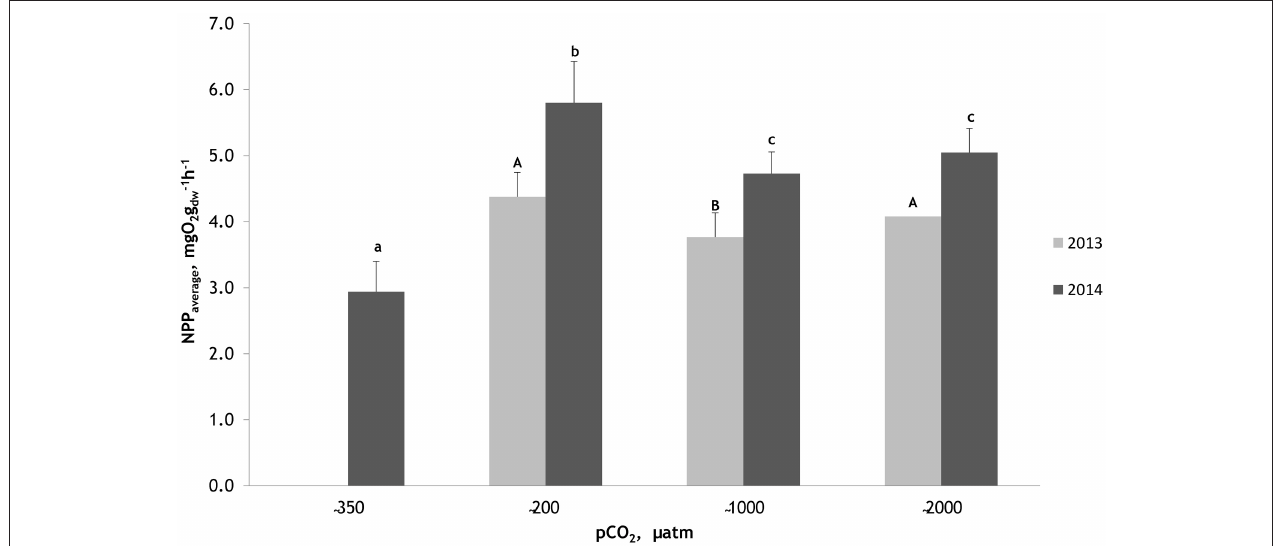
FIGURE 1 | Mean net photosynthetic rates measured during two experimental periods (18 July 2013–27 July 2013 and 16 July 2014–26 July 2014) for seagrass Zostera marina at different water pCO 2 levels. Within experimental periods, same uppercase letters in 2013 and lowercase letters in 2014 indicate that net photosynthetic rates are not significantly different from one another (PERMANOVA pair-wise test for factor CO 2 ). Bars represent mean ± deviation (in mesocosm 2013 ( n = 30), 2014 ( n = 33) and in natural conditions 2014 ( n = 11).